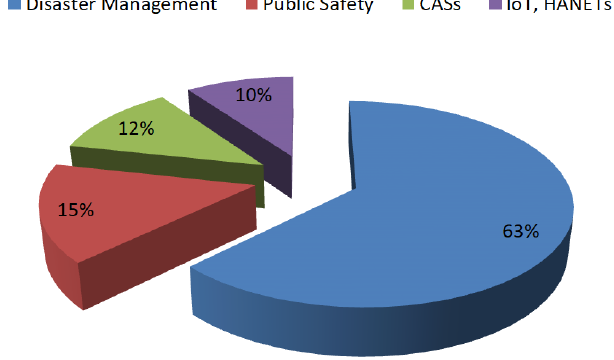
Figure 5. Key applications and services of D2D MHMP